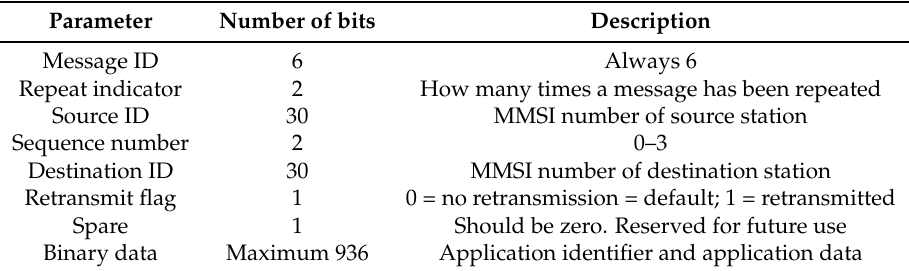
Table 3. Parameters of the addressed binary message.